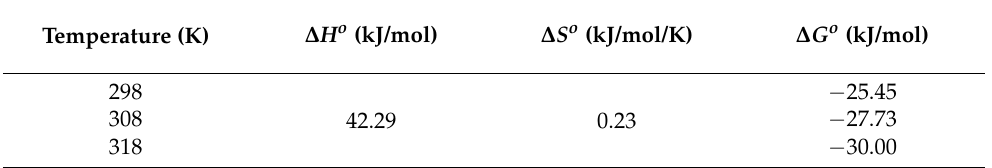
Table 3. Thermodynamic parameters for 1V: 9Mn NVP@NMP.